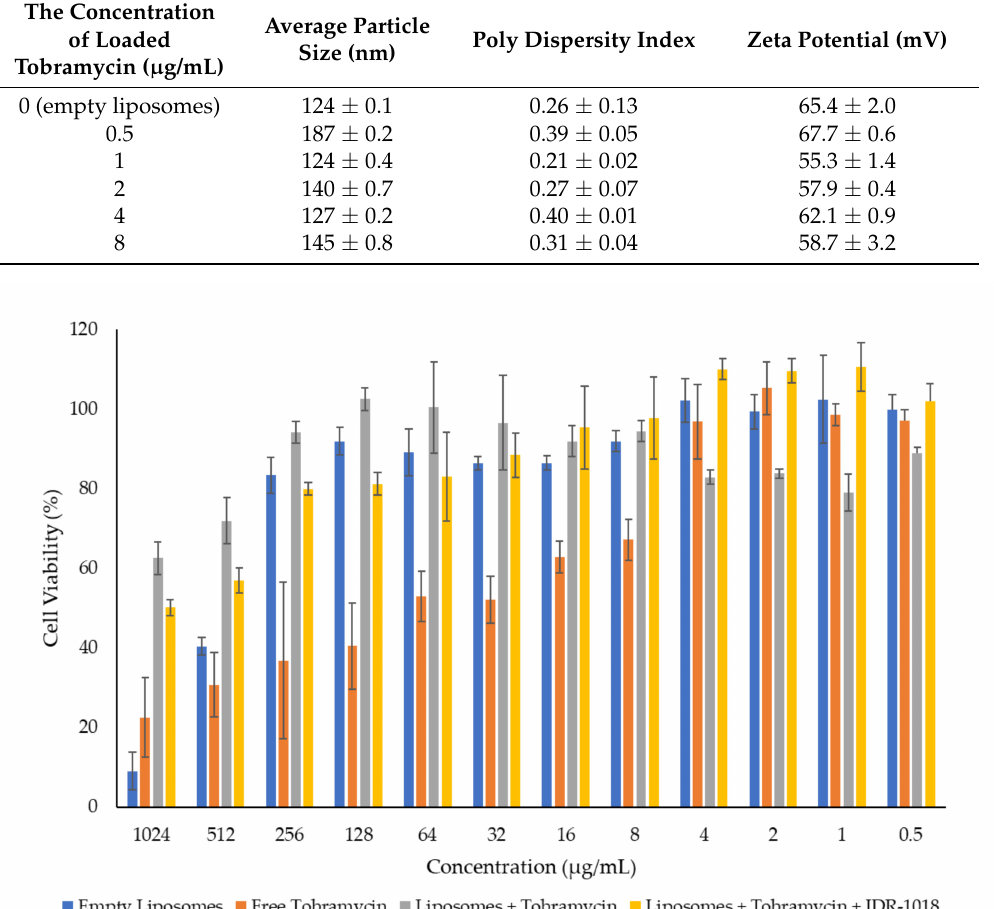
Table 2. Particlesizeandzetapotentialmeasurementsofthepreparedliposomes, withorwithouttobramycin.